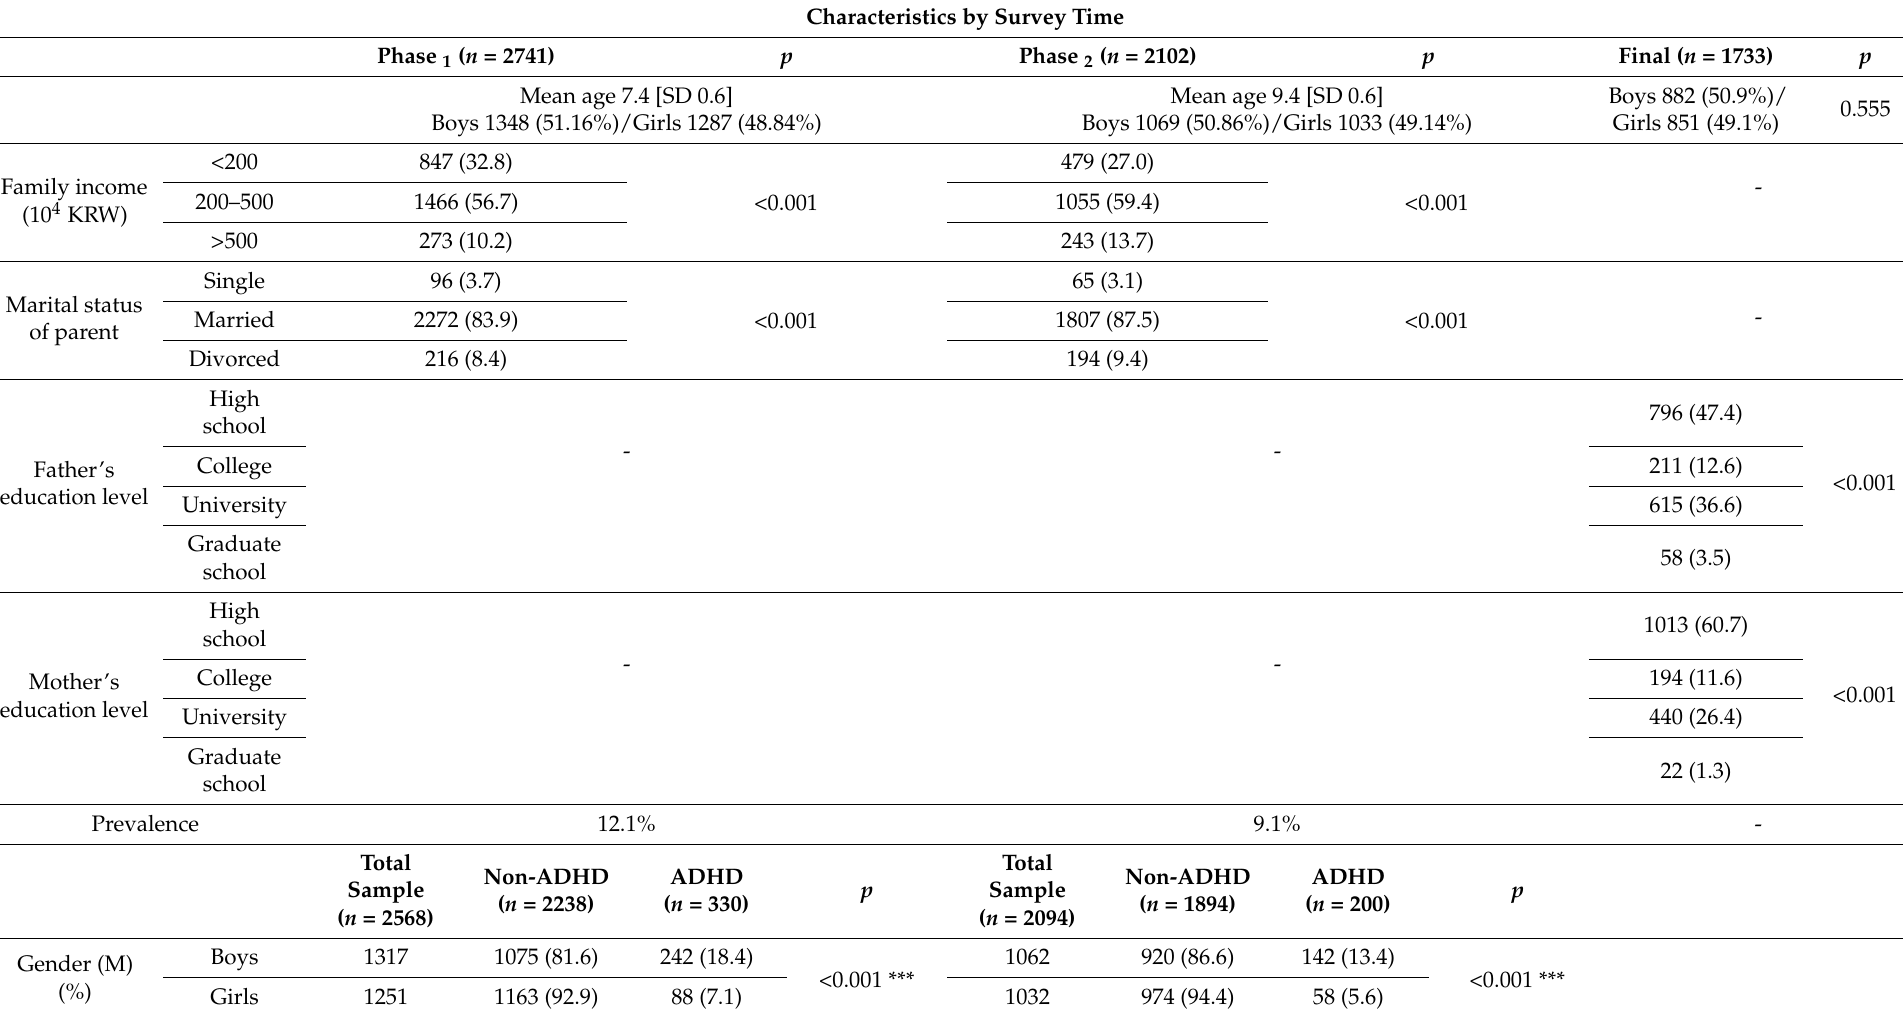
Table 1. The characteristics of the study population by the diagnosis of ADHD (1)